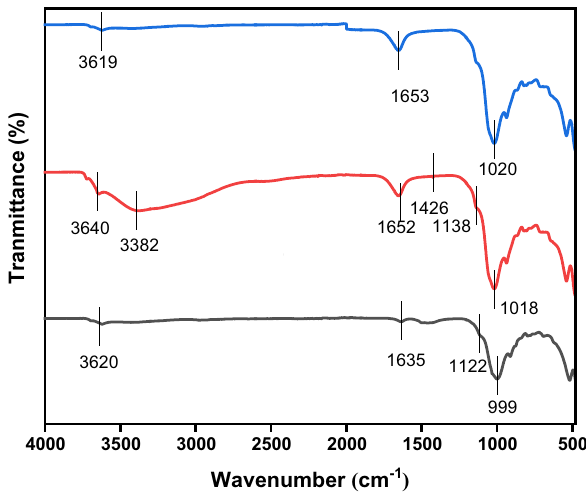
Fig. 2 FTIR spectra of Na-MMt and His-MMt before and after